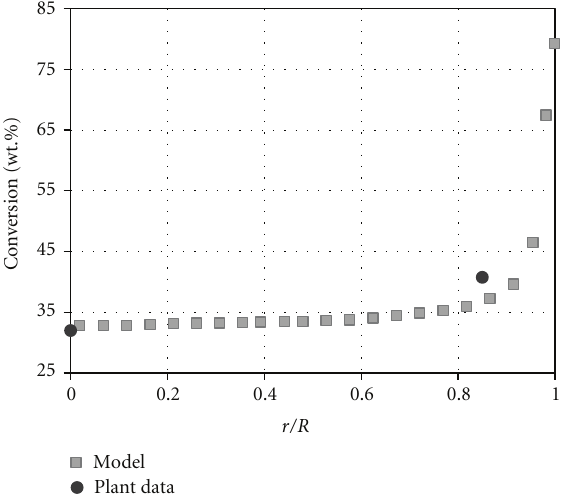
Figure 13: Radial profile of cracking